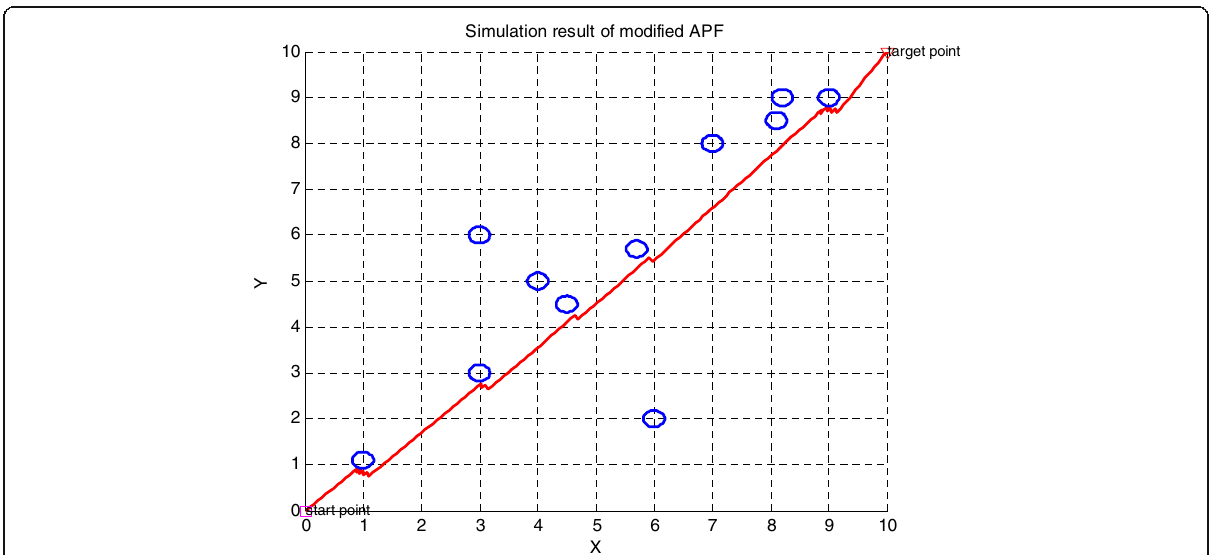
Fig. 11 The simulation result of the modified artificial potential field algorithm for circular obstacles with radius R = 0.18